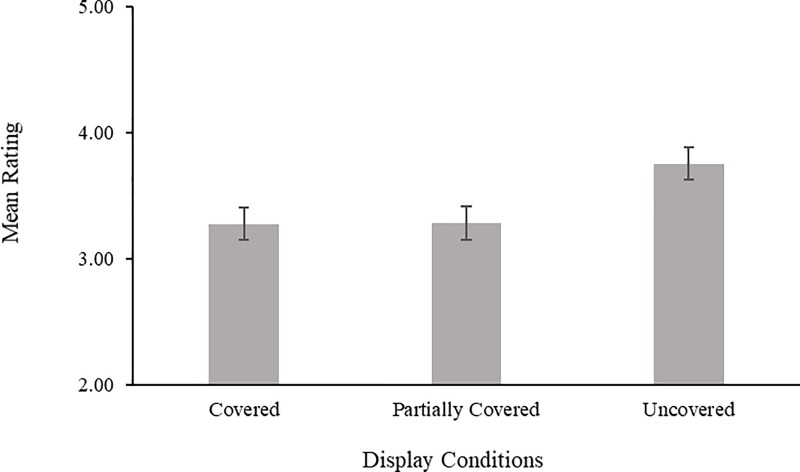
Mean attractiveness ratings for covered, partially covered, and uncovered images.Ratings in the experiment were on a scale of 1–7 and the scale here has been adjusted for clarity.